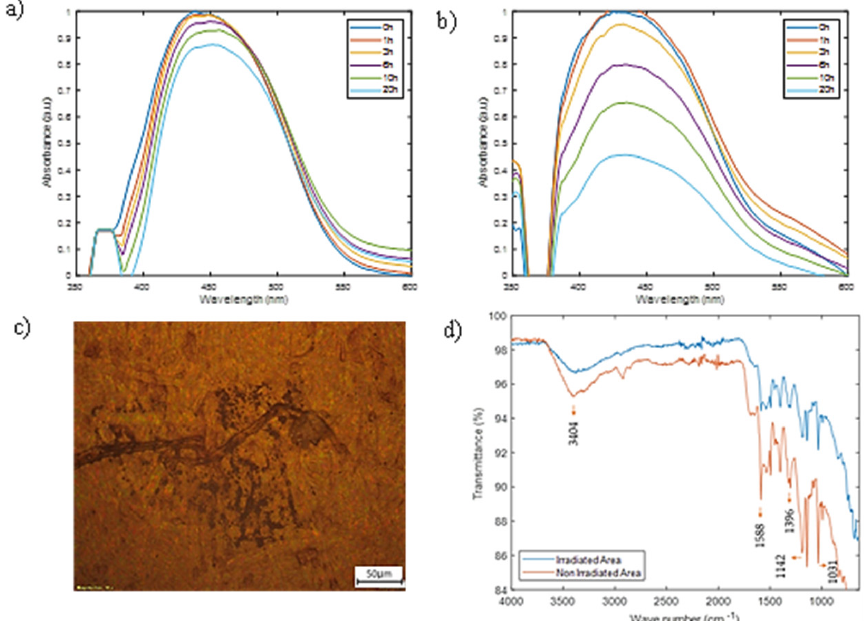
Figure 11. ( a ) Evolution of the degradation rate of MY deposited into sample S0 for a total irradiation time of 20 h; ( b ) evolution of the degradation rate of MY deposited into S5 sample for a total irradiation time of 20 h; ( c ) optical microscopy image of a micrometric degraded zone of the dye in sample S01; ( d ) FTIR spectra of the irradiated and non-irradiated area of the Metanil Yellow sample.